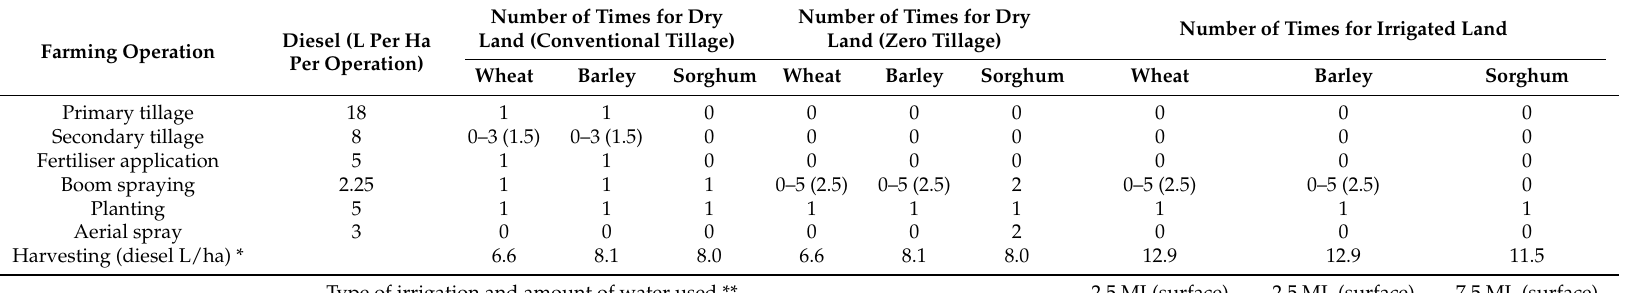
Number of Times for Irrigated Land